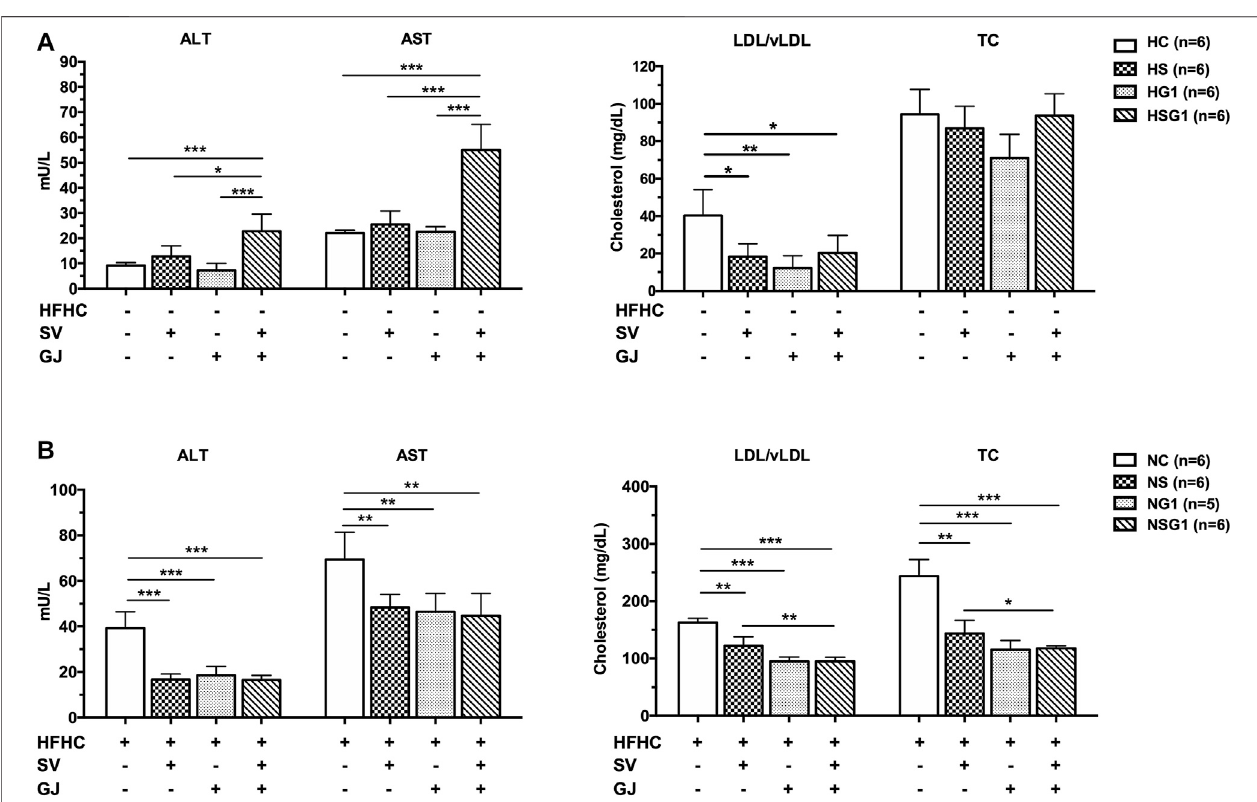
FIGURE5| ALT,AST,LDL/vLDL,andTClevelsinthefastingserumofhealthy (A) andNASH (B) ratsaftertwo-weektreatmentsofvehicle(HCandNC),SV(HSand NS), GJ (HG1 and NG1), and their combination treatment (HSG1 and NSG1). H and N denoted healthy and NASH, respectively. C, S, and G indicated that the rats received vehicle, SV, and GJ,